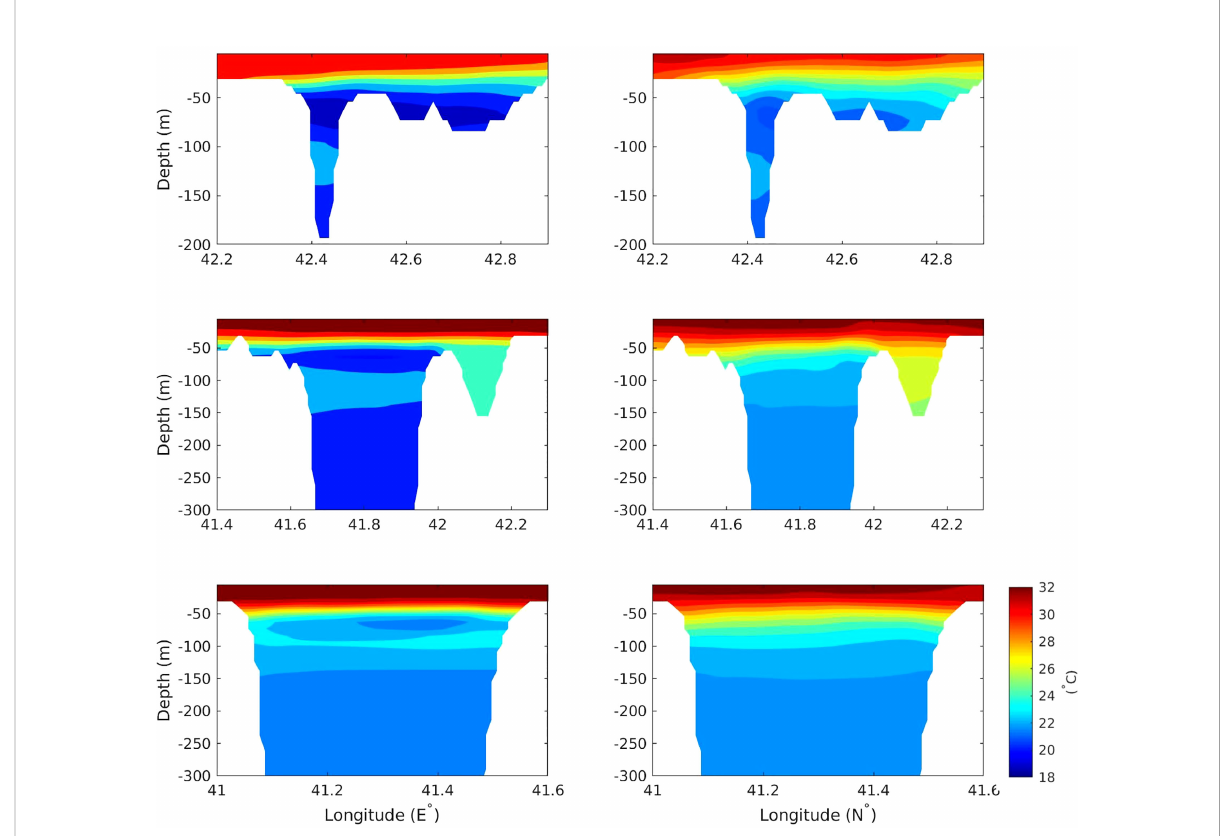
FIGURE 5 The comparisons of the cross-section extension of the summer intrusion of GAIW between the runs without tides (left panels) and with tides (right panels). The three panels from top to bottom represents the potential temperature fi elds of three cross-sections indicated by while dash- lines (Lines 1, 2 and 3) in Figure